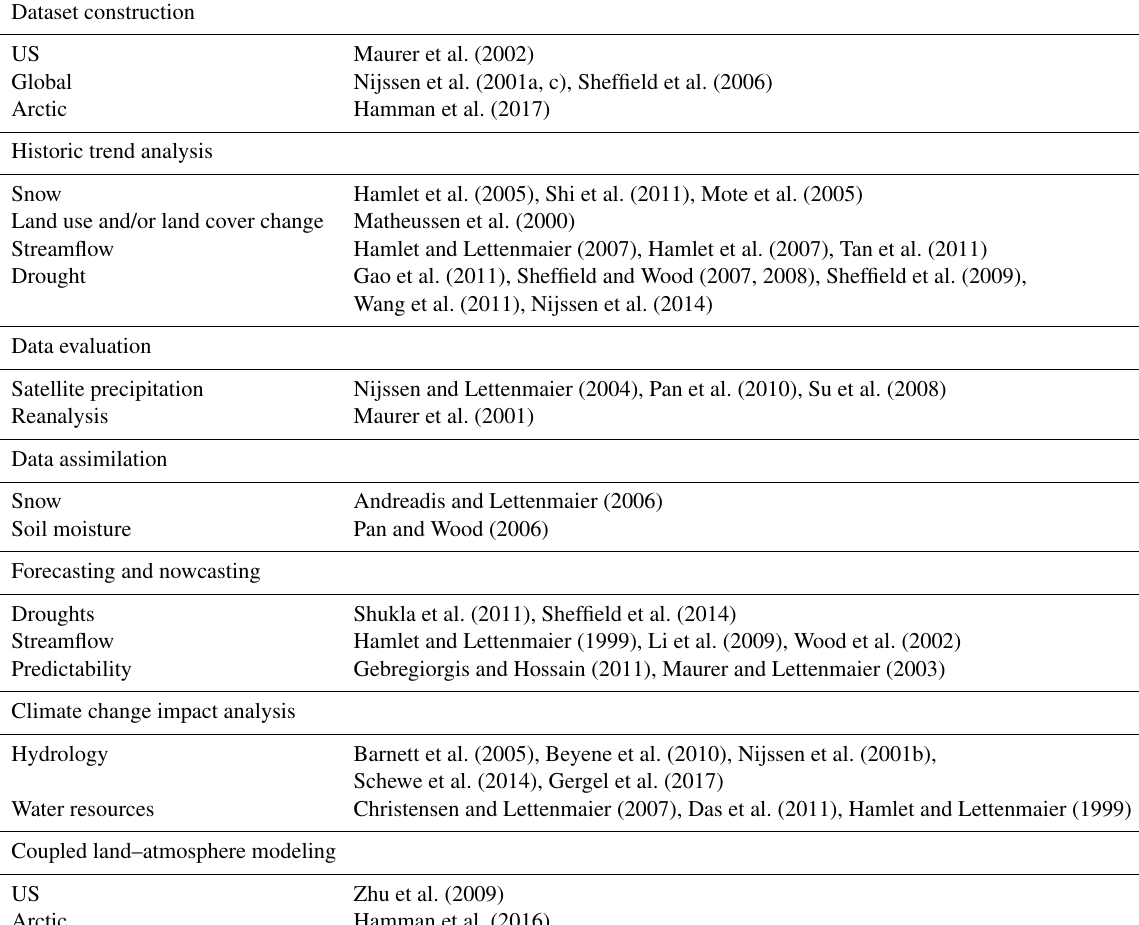
Table 1. Examples of VIC applications. Dataset